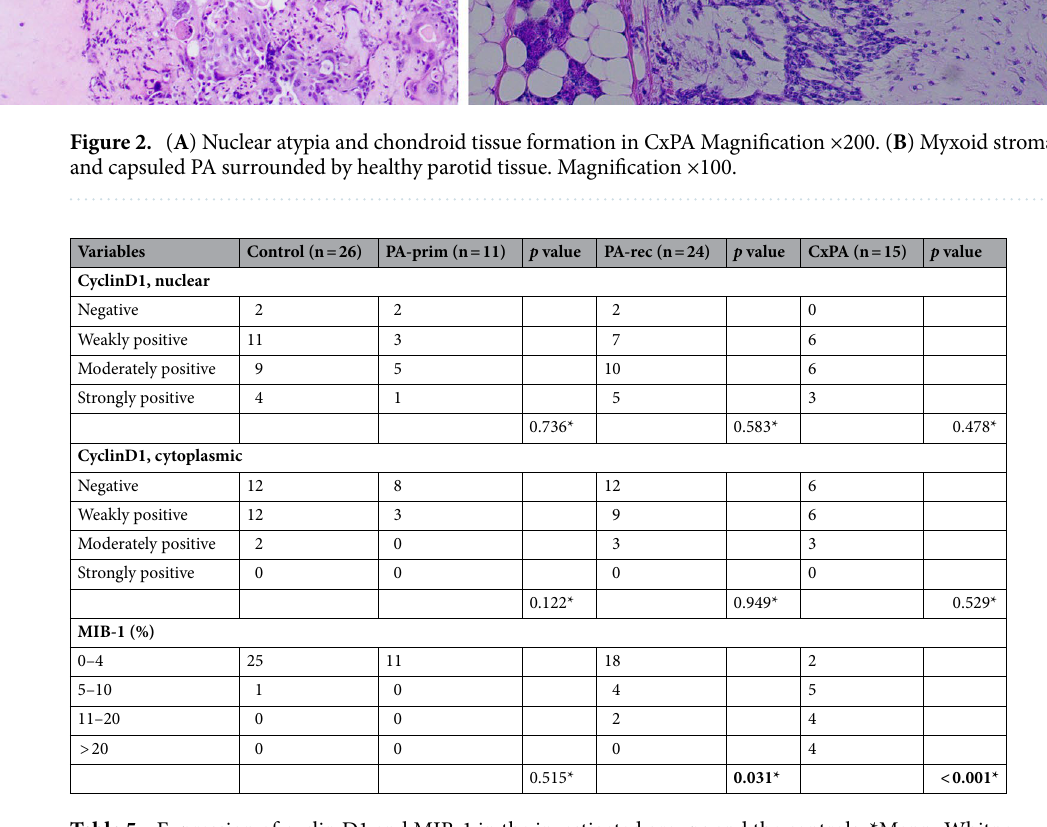
Table 5. Expression of cyclin D1 and MIB-1 in the investigated groups and the controls. *Mann–Whitney U, Asymp. Sig (2-tailed). Bolded p values are statistically significant. Statistically significant p value p < 0.05. RPA = Patients with recurrent pleomorphic adenoma. CxPA = Patients with carcinoma ex pleomorphic adenoma. PA-prim = Primary tumors of RPA patients. PA-rec = Recurrent tumors of RPA patients.